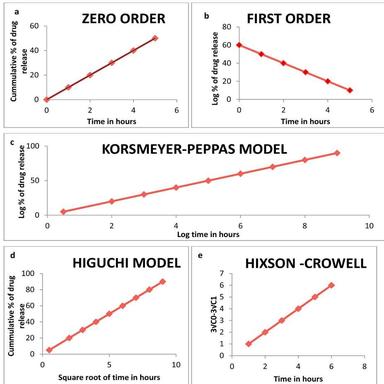
Graphs of mathematical models used to evaluate release kinetics (a)Zero order release graph is linear plot between time taken on x-axis and cumulative percentage on y-axis (b) First order release graph is linear plot between time taken on xaxis and cumulative percentage of drug remaining to be release on y-axis (c)Korsmeyer-Peppas model graph is linear plot between time taken on x-axis and log cumulative percentage of drug release on yaxis (d) Higuchi model graph is linear plotted between the square root of